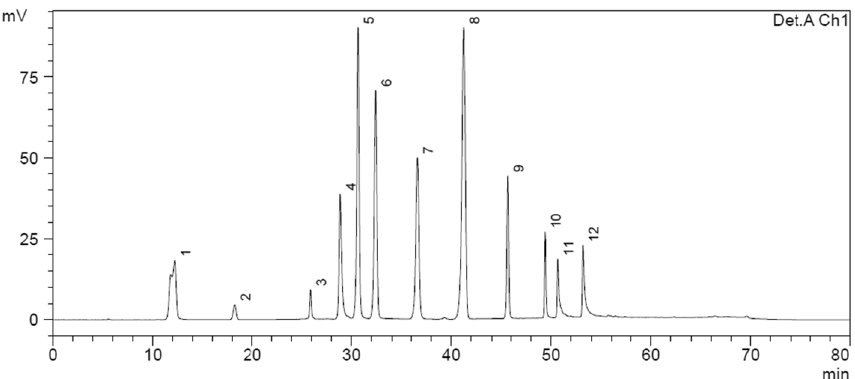
Figure 3. Chromatogram of analytical standards: (1) gallic acid; (2) catechol; (3) catechin; (4) chlorogenic acid; (5) caffeic acid; (6) vanillin; (7) syringaldehyde; (8) p-coumaric acid; (9) coumarin; (10) rutin; (11) myricetin and (12)